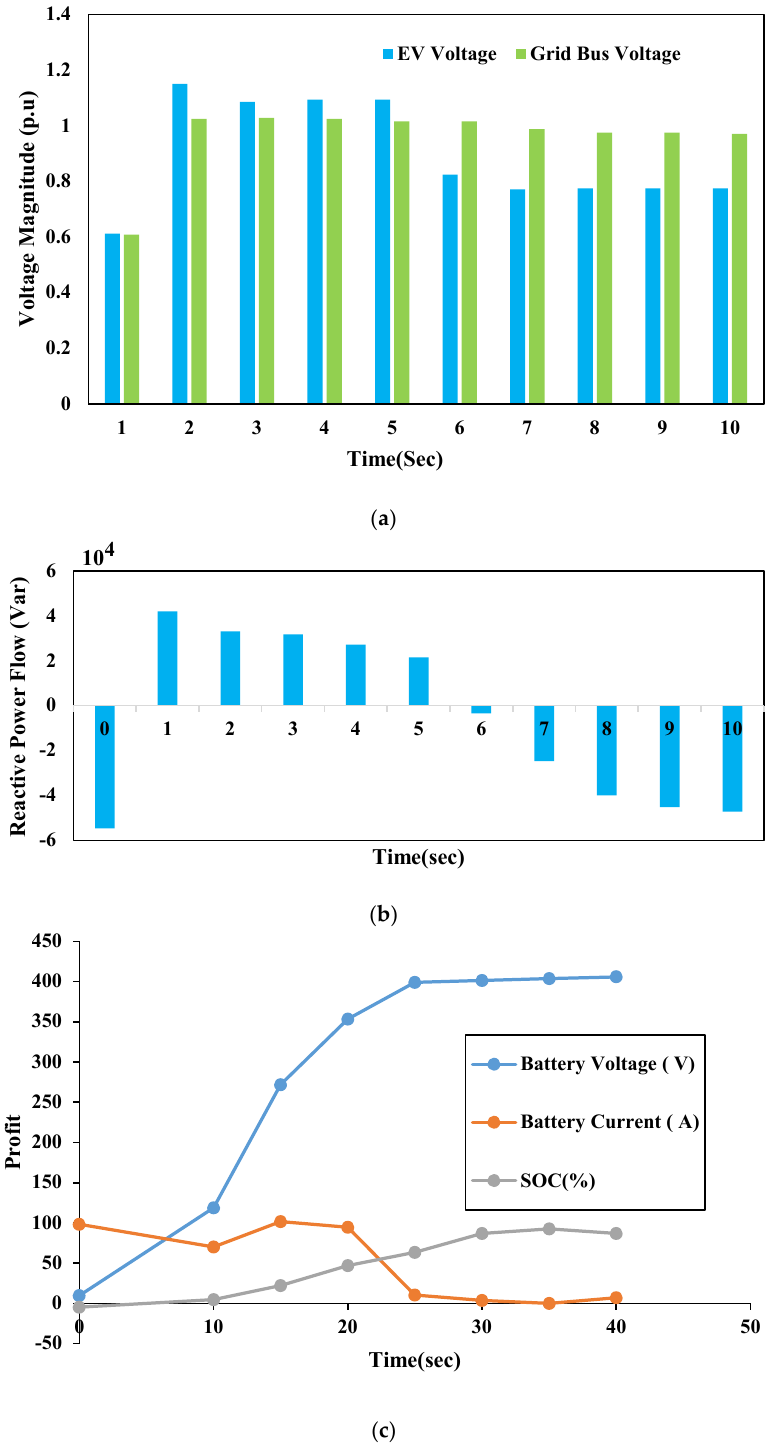
Figure 13. Reactive power exchange and battery charging ( a ) the voltage difference between the EV system and the grid. ( b ) Reactive power exchange in grid ( c ) Battery charging waveforms in the CC/RCC are charging methods.